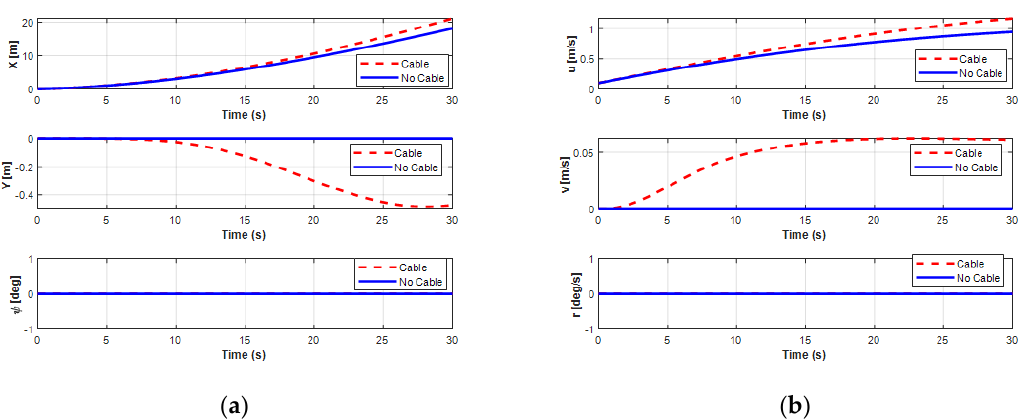
Figure 29. Simulation results of position and velocity of the USV doing the forward motion: ( a ) position of the USV; ( b ) velocity of the USV.